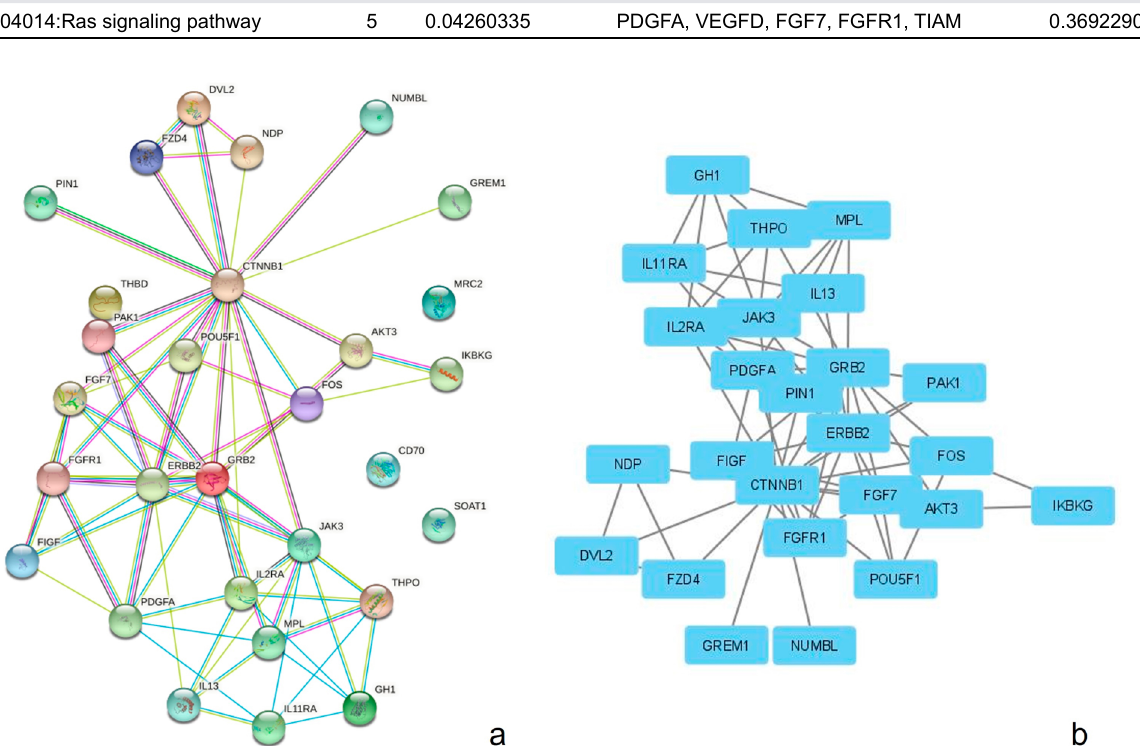
Figure 1- PPI of the differentially expressed genes constructed using STRING online database and Cytoscape software analysis. a) A total of 31 differentially expressed genes were identified in the network. b) Module analysis via Cytoscape software (degree cutoff=2, node score cutoff=0.2, k-core=2, and max